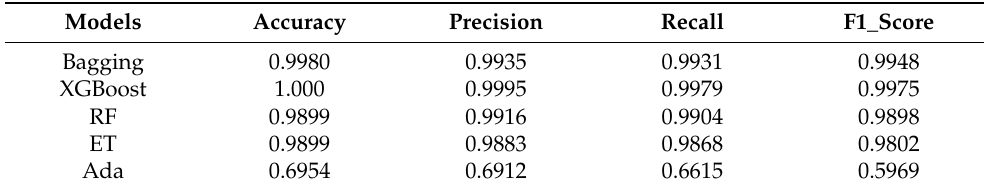
Table 11. Combined_IoT_Dataset Evaluation of Binary Classification